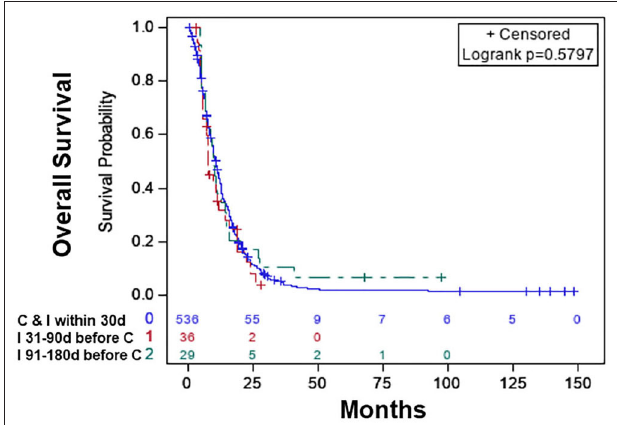
FIGURE 2 | Overall survival of patients with chemotherapy plus immunotherapy with or without radiation therapy: chemotherapy and immunotherapy started within 30 days of each other (blue), immunotherapy started 31–90 days before the start of chemotherapy (red), immunotherapy started 91–180 days before the start of chemotherapy (green).